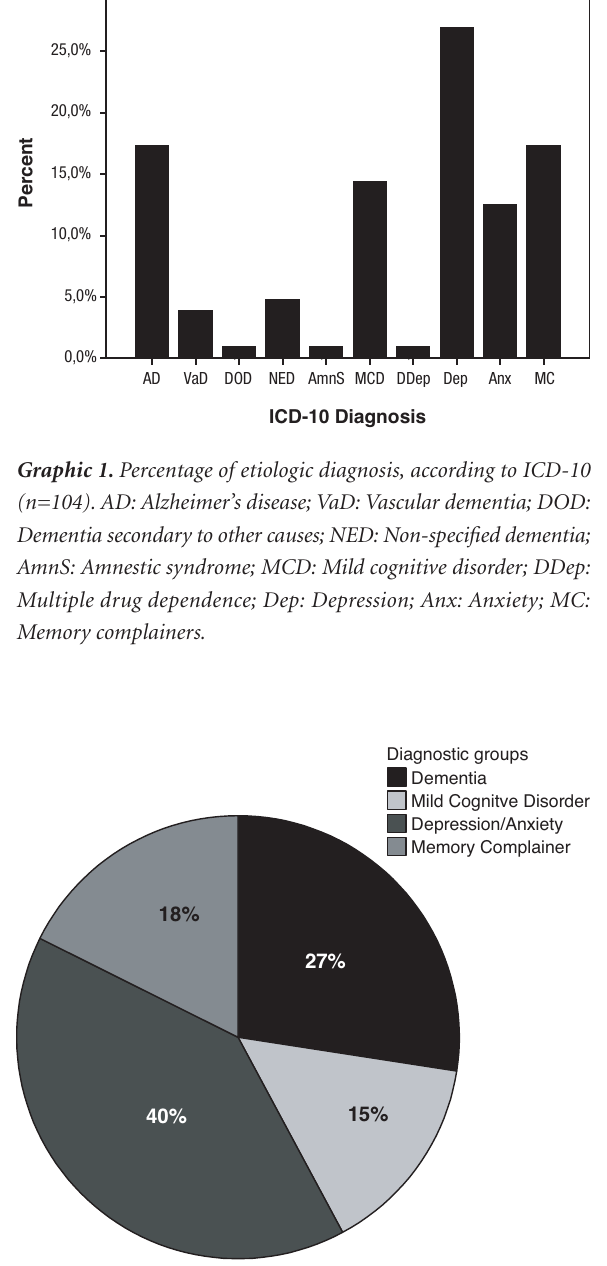
mean ages and schooling, whereby patients with dementia were older than those with depression or anxiety and with memory complaints, and less educated than subjects with memory complaints. Comparing MMSE and CAMCOG mean score, the group with dementia presented signifi- cantly lower test scores compared to the other 3 groups, with age and schooling as